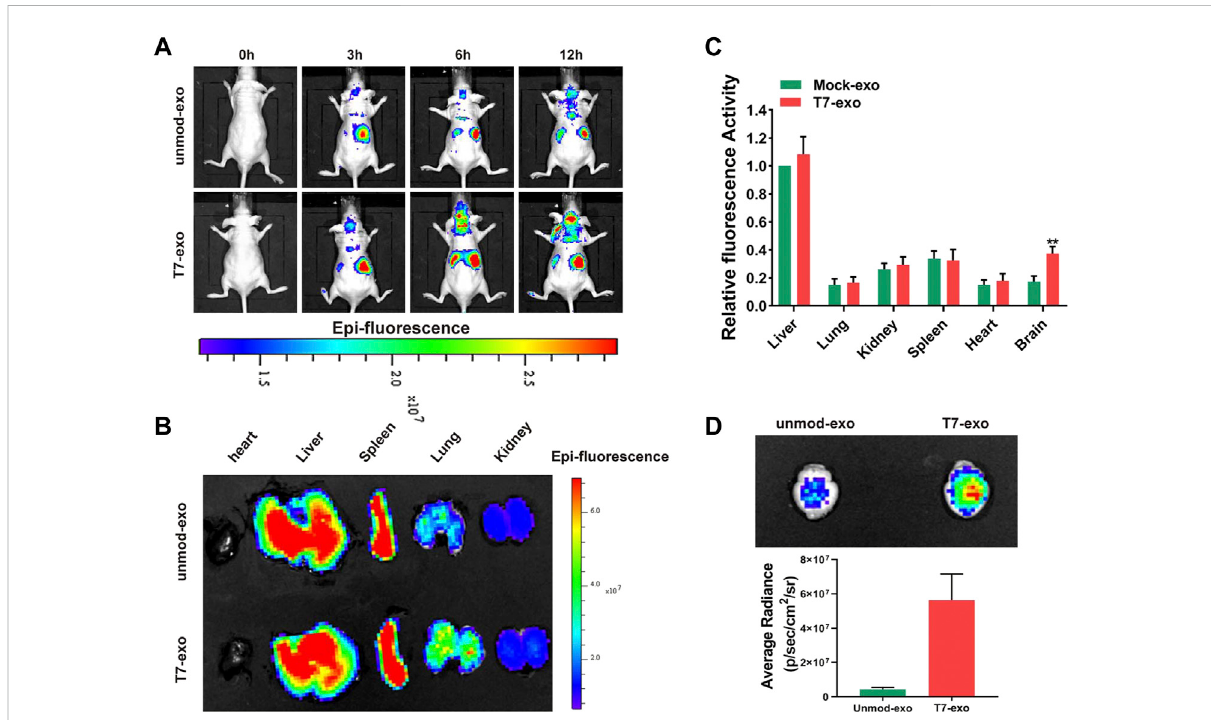
FIGURE 5 Tumor targeting ability of T7-siYY1-exo in orthotopic GBM xenograft model using LN229 cells. (A) In vivo fl orescence imaging of Orthotopic GBM xenograft mice at 0, 3, 6 and 12 h time point after intravenous administration of unmod-exo/T7-siYY1-exo (200 ug). (B) Ex vivo fl uorescence imagesofLiver,Spleen,Lung,HeartandKidneyfrommicesacri fi cedat12 hpost-injection. (C) Fluorescencequantitativeanalysisof exvivo organsof LN229 tumor-bearing mice after intravenous injection. p values are displayed as * p ≤ 0.05, ** p ≤ 0.01, *** p ≤ 0.001. (D) Ex vivo images and quantitative analysis of the GBM-bearing